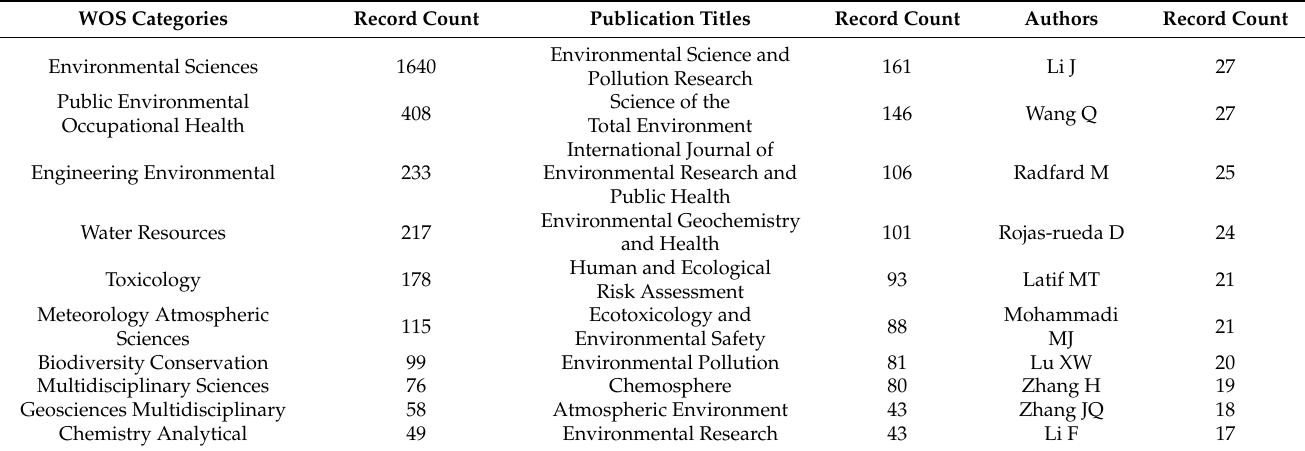
Table 1. Top 10 WOS of categories, publication titles and authors.